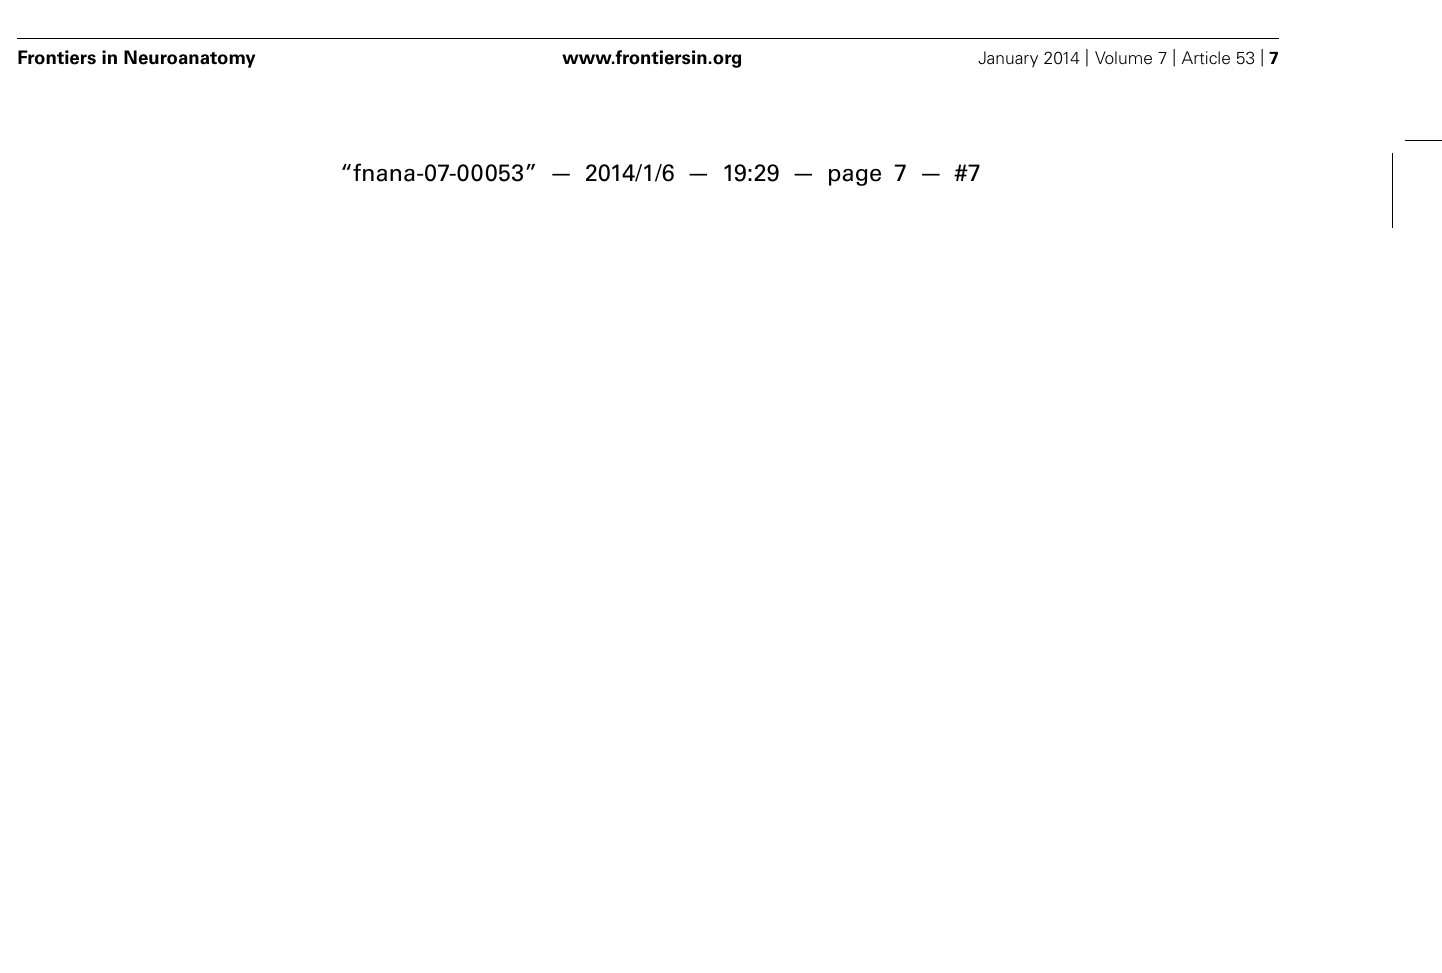
protein, somatic staining in the LDT is abolished (top) but PN-like staining in the ICc remains (bottom). (C) . Following pre-adsorption of the anti-VAChT antibody with N -acetylgalactosamine (GalNac, the target of WFA binding), somatic staining is present in the LDT (top), but net-like staining in the ICc is abolished (bottom). Scale bar = 50 μ m. Case